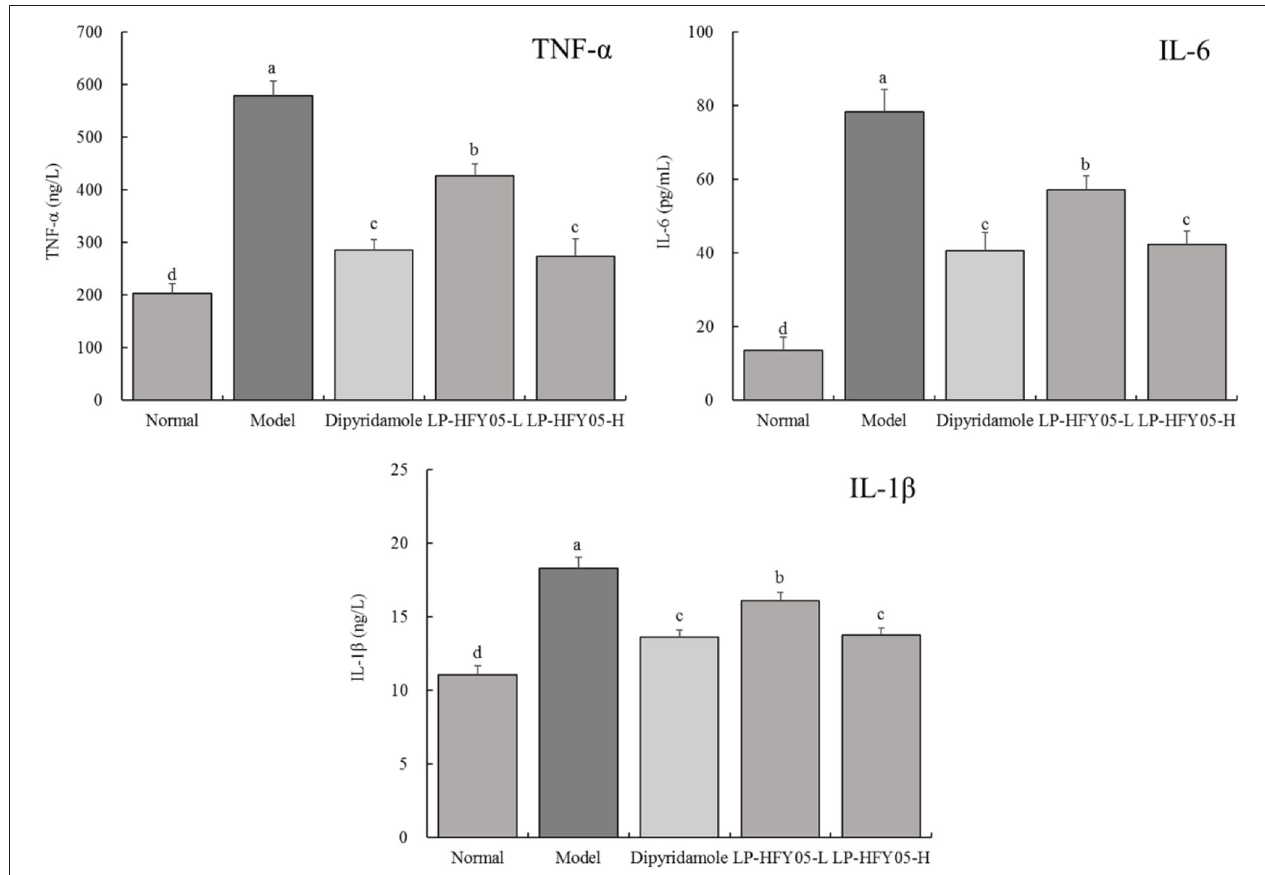
FIGURE 2 | TNF- α , IL-6, and IL-1 β levels in serum of mice with thrombosis. a − d Mean values with different letters in the different bars were significantly different ( P < 0.05) according to the SNK multiple-range test; b, c, and d indicate significance vs the model group; the same letter of c indicates that there was no significant difference ( P > 0.05) between the two